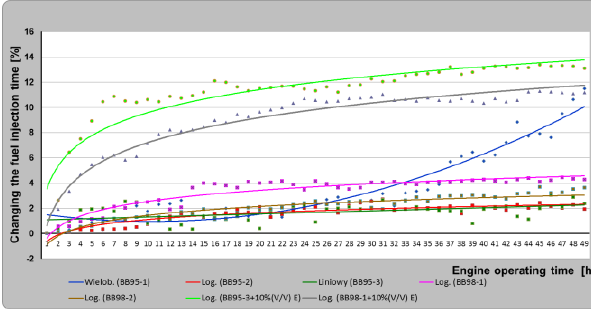
Fig. 6. Summary of trend lines of fuel injection time changes for the tested gasoline